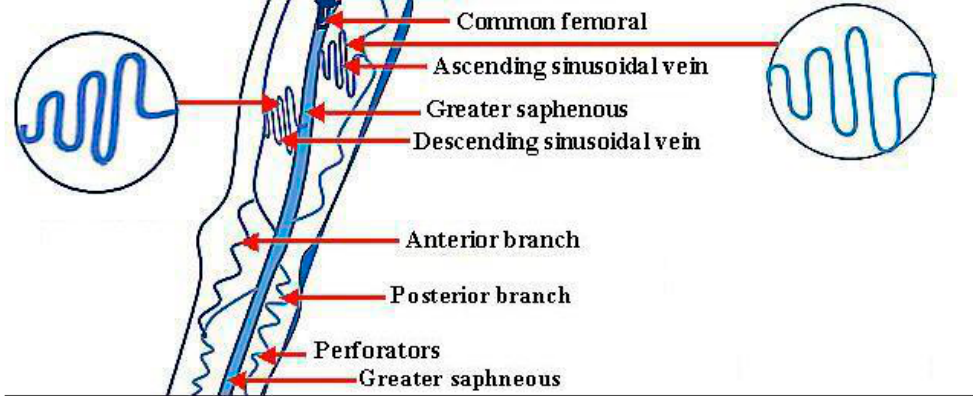
Figure 1. Normal veins which can become varicose veins.